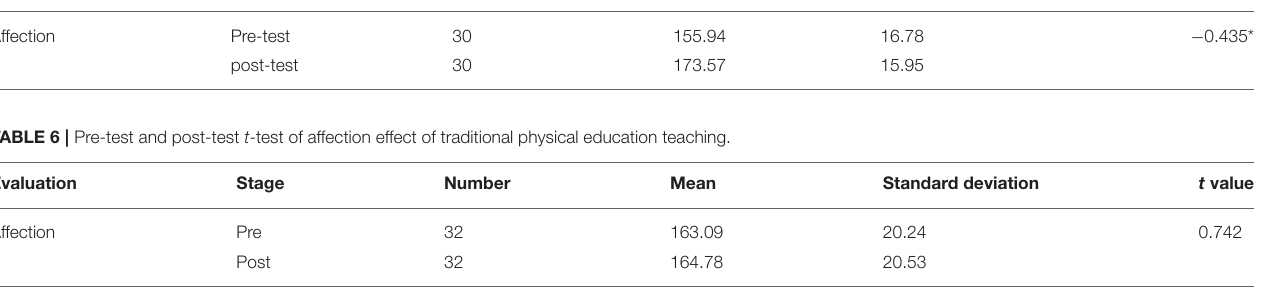
TABLE 5 | Pre-test and post-test t-test of affective learning outcomes of sports education model. Evaluation